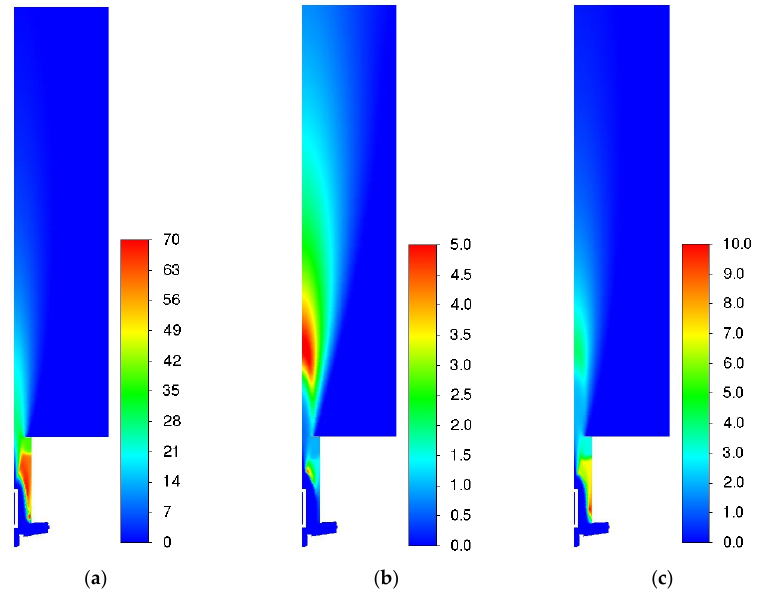
Figure 9. Concentration of nitrogen oxides, ppm: ( a ) k-e; ( b ) k-w SST; ( c ) RSM.